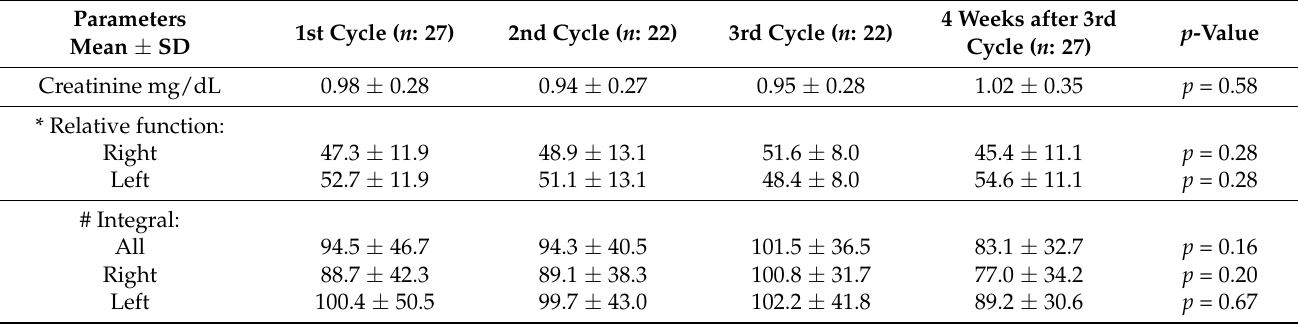
Table 3. Serum kidney and isotope nephrogram ([ 99 Tc]Tc-MAG 3 ) parameters directly before each cycle and 4 weeks after receiving 3 cycles of PSMA-RLT.